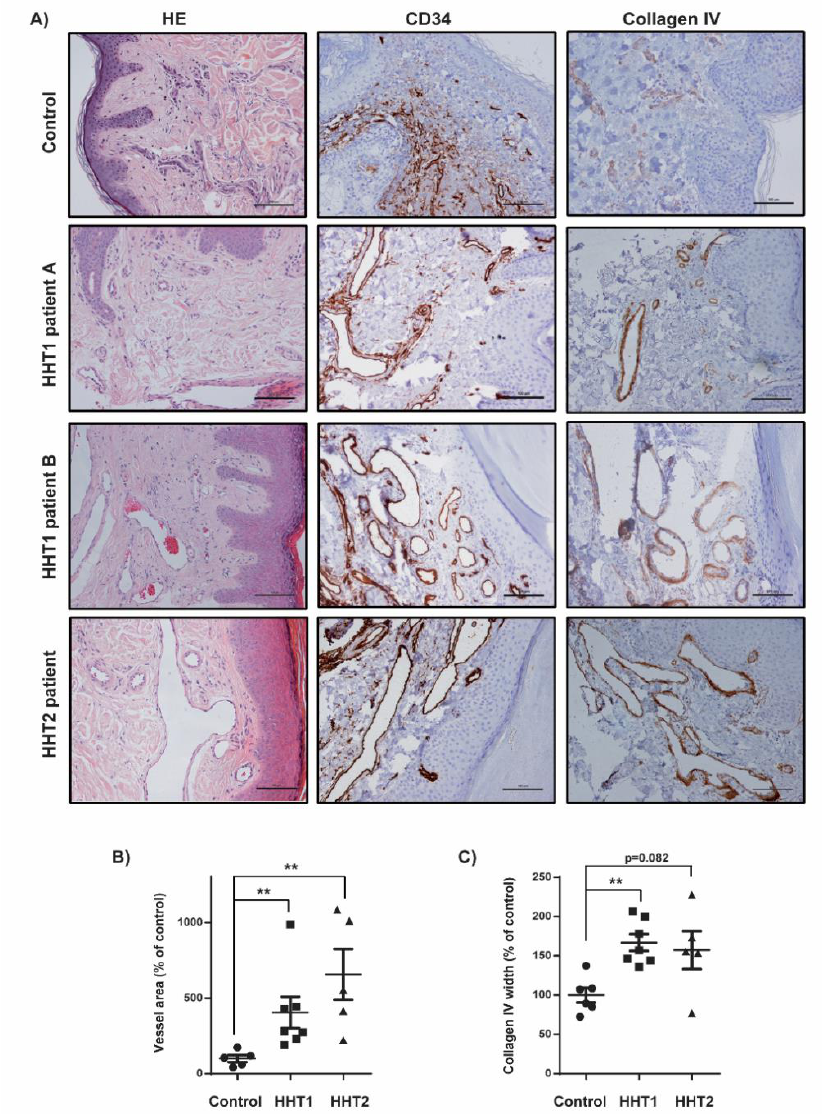
Figure 2. Increased vessels size and collagen IV staining in HHT1 and HHT2 cutaneous telangiectasia biopsies. ( A ) Hematoxylin and eosin (HE), CD34, and collagen IV staining of one control, two HHT1 patients and one HHT2 patient biopsies. Scale bars, 100 µm. ( B ) Quantification of the vessel area in controls (n = 6), HHT1 (n = 7), and HHT2 patients (n = 5). Results are represented as % relative to the control. Error bars indicate the standard error of the mean. Statistical significance of two-tailed Mann–Whitney U tests: ** p < 0.01. ( C ) Quantification of the collagen IV width in controls (n = 6), HHT1 (n = 7), and HHT2 patients (n = 5). Results are represented as % relative to the control. Error bars indicate the standard error of the mean. Statistical significance of two-tailed Mann–Whitney U tests: ** p <